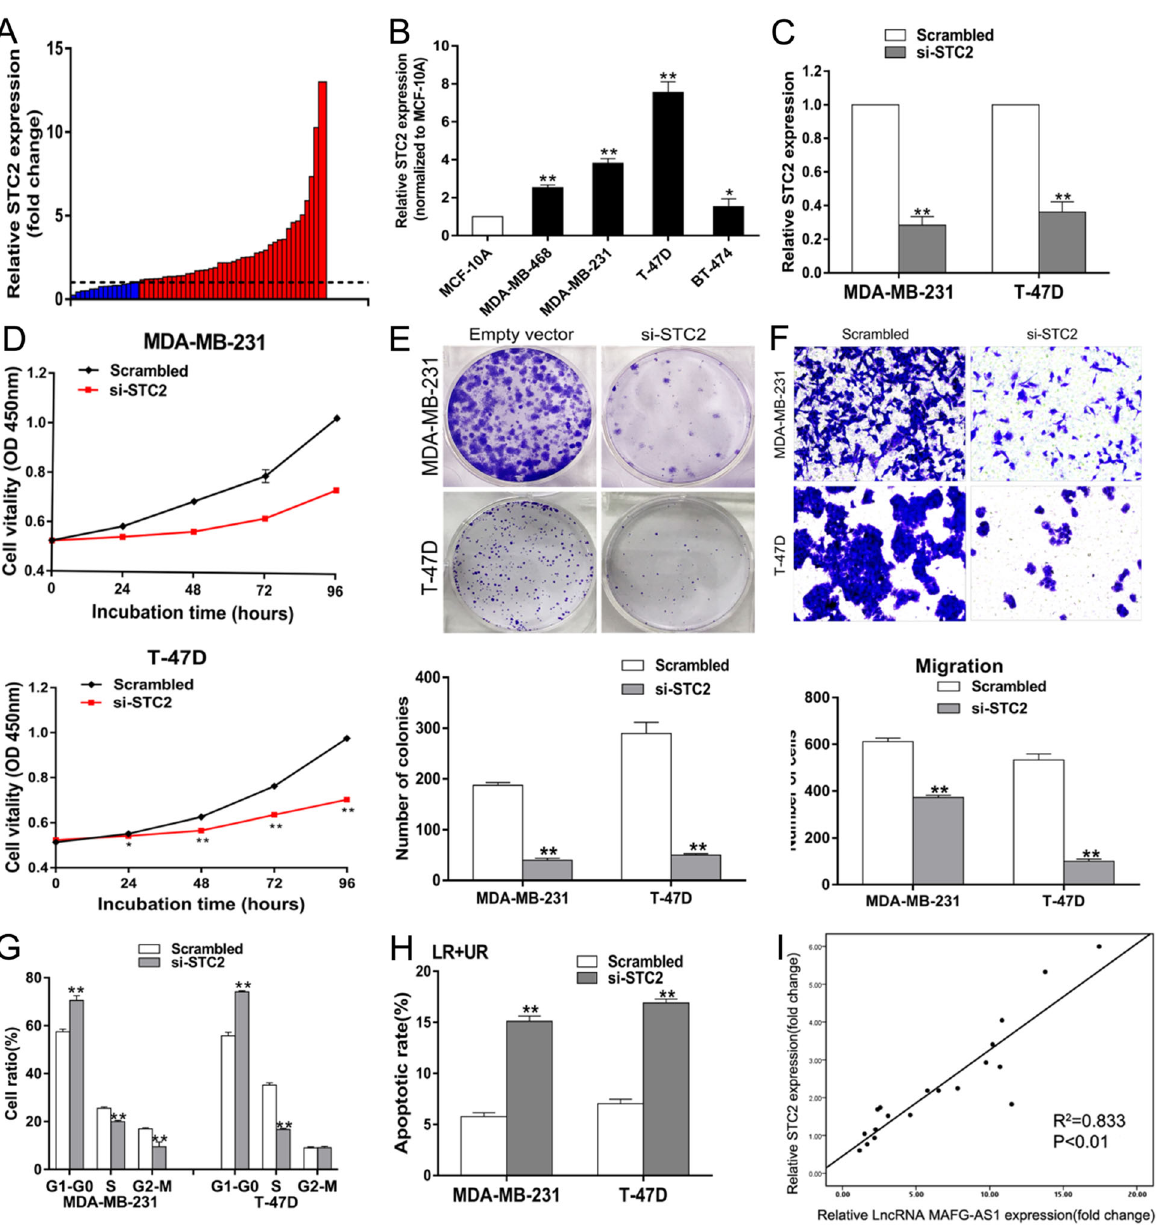
Fig. 7 Downregulation of STC2 inhibits BC cells proliferation and is involved in the oncogene function of LncRNA MAFG-AS1. A Relative expression of STC2 in BC tissues ( n = 54) and the paired noncancerous tissues ( n = 54) analyzed by qRT-PCR and normalized to GAPDH. B qRT- PCR assay examined STC2 expression in normal breast epithelial cell line (MCF-10A) and BC cell lines. C qRT-PCR analysis of STC2 expression in BC cells transfected with control (scrambled) and si-STC2. D CCK8 assays were performed to determine viability of BC cells treated with the control and si-STC2. E Colony formation assays were used to detect the proliferation of si-STC2-transfected BC cells. Colonies were counted and captured. F Transwell assays were conducted to evaluate migration of BC cells. G , H Cell cycle and apoptosis of BC cells were investigated by fl ow cytometry. I Analysis of the relationship between STC2 and LncRNA MAFG-AS1 expression. * P < 0.05, ** P <